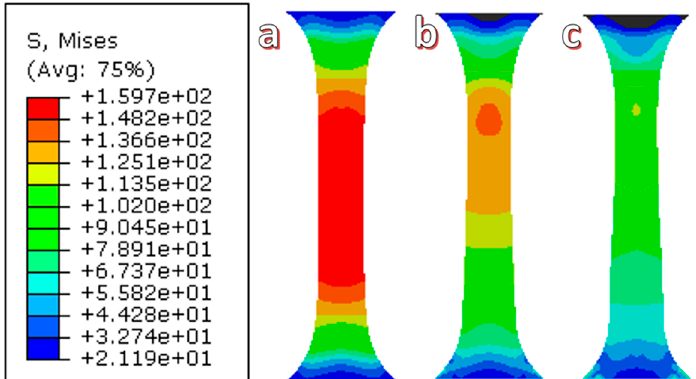
Figure 9. The distribution of the simulated equivalent stress the uniaxial tensile of Zr35 at different ultrasonic vibration amplitudes: ( a ) 0 μ m; ( b ) 12 μ m; and ( c ) 24 μ m.